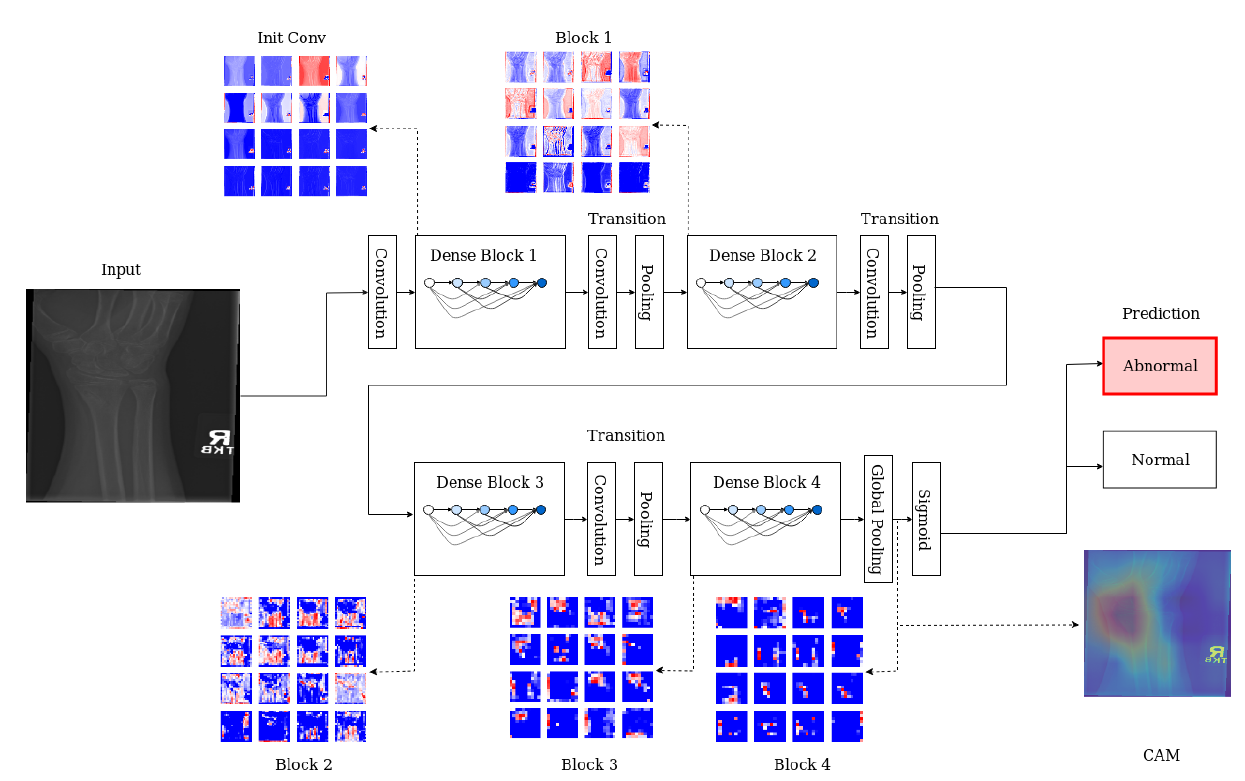
Figure 4. Schematic illustration of the X-ray classification process and class activation mapping through layer-wise activation maps across different dense blocks. At each level, a series of feature maps are generated, the resolution decreases progress through the blocks. Colours indicate the range of activation: blue corresponds to low activation, red for highly activated features. The final output, visualised here using class activation mapping, which highlights the area(s) where abnormalities can be